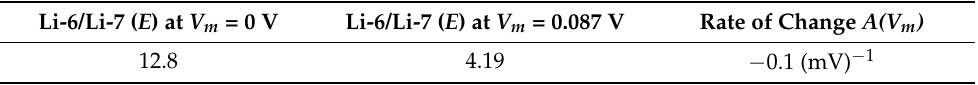
Figure 14. The figure represents the relationship between the ratio of the extracellular lithium isotopes Li-6/Li-7 ( E ) and the membrane potential when setting G = 5 J and L = 1 m. Table 34. The table shows the ratio Li-6/Li-7 ( E ) that can take the range between the two values at V m = 0 V and at V m = 0.087 V and shows the rate of change in the ratio with respect to the membrane